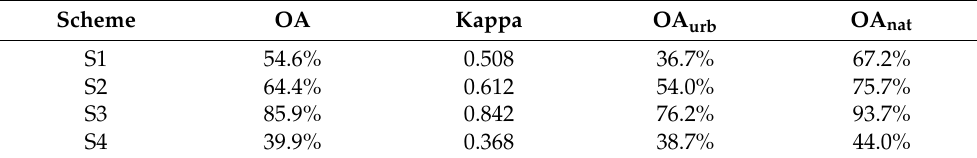
Table 4. Accuracy of the four